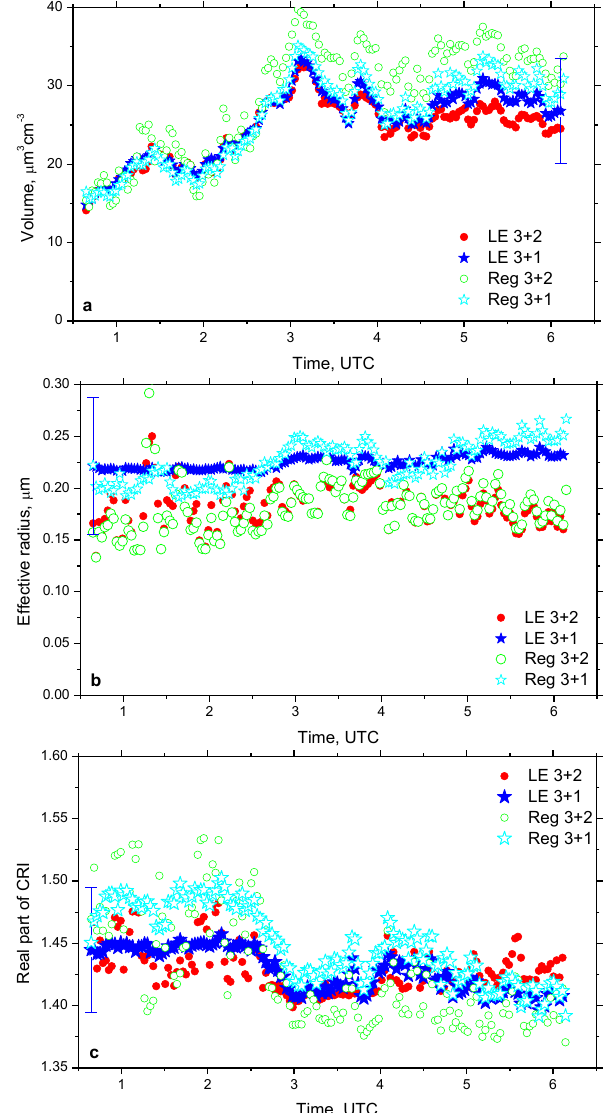
Fig. 10. Retrieval of (a) effective radius, (b) volume density and Fig.10. Retrieval of (a) effective radius, (b) volume density and (c) the real part of CRI from (c) the real part of CRI from measurements on the night of 20– measurements on the night of 20-21 July 2011, the optical data are averaged in 2000-2500 m 21 July 2011; the optical data are averaged in 2000–2500m layer. Results are given for regularization and LE techniques applied to layer. Results are given for regularization and LE techniques applied to 3β+2  and 3β+1  3 β + 2 α and 3 β + 1 α measurements.